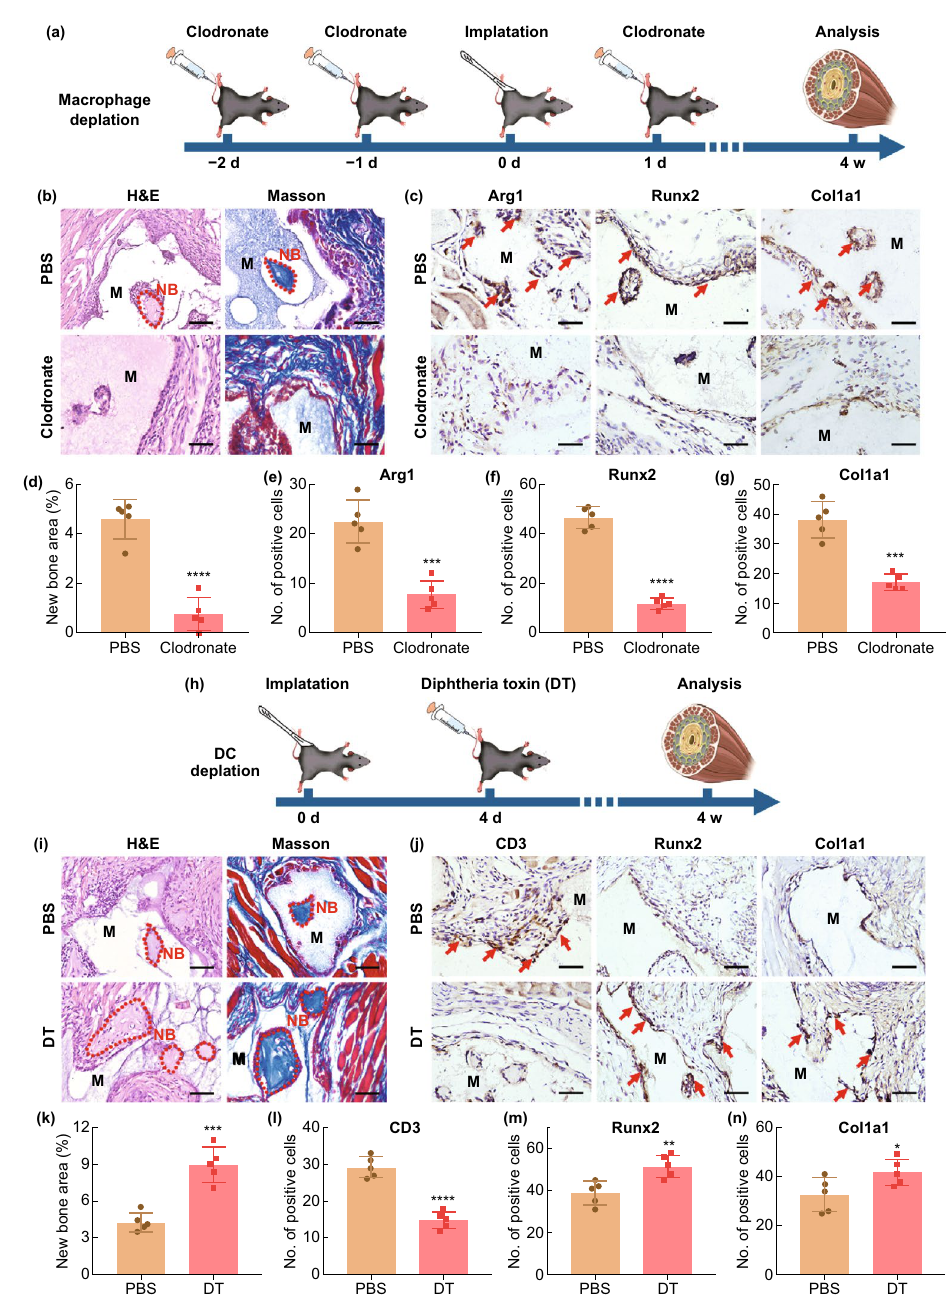
Fig. 6 a Implementation strategy of clodronate on macrophages depletion. b H&E and Masson staining of BCP implant area treating with PBS or clodronate in vivo after implant 4 weeks (the red dash line shows the new bone formation area; NB, new bone; M, material). Scale bar = 100 μm. c IHC staining of M2 macrophages (Arg1) and osteoblasts (Runx2, Col1a1) under the BCP implant treating with PBS or clo- dronate in vivo. Scale bar = 100 μm. Red arrow, positive cells. M, material. d – g Semiquantification of new bone area and positively stained cells in ( b, c ). n = 5, *** P < 0.001, **** P < 0.0001. h Implementation strategy of diphtheria toxin (DT) on DCs depletion. i H&E and Masson stain- ing of BCP implant area treating with PBS or DT in vivo after implant 4 weeks (the red dash line shows the new bone formation area; NB, new bone; M, material). Scale bar = 100 μm. j IHC staining of T cells (CD3) and osteoblasts (Runx2, Col1a1) under the BCP implant treating with PBS or DT in vivo. Scale bar = 100 μm. Red arrow, positive cells. M, material. k – n Semiquantification of new bone area and positively stained cells in ( i, j ). n = 5, * P < 0.05, ** P < 0.01, *** P < 0.001, **** P <